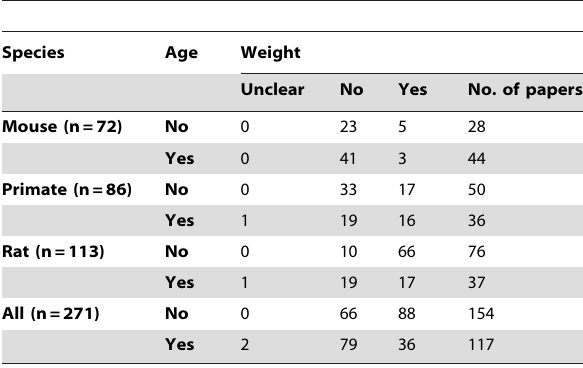
Table 8. Number of studies reporting the age and weight of the animals.